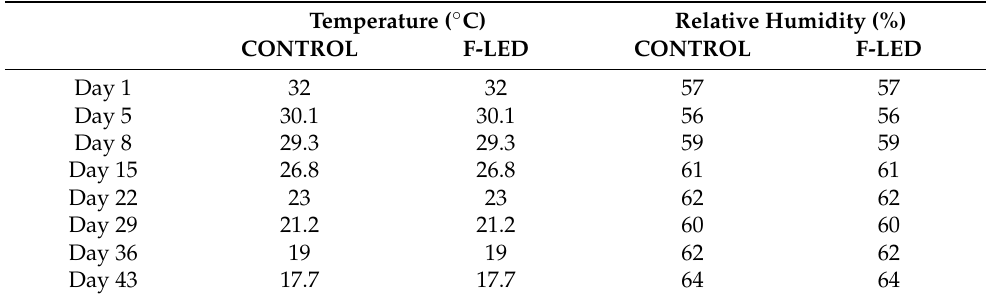
Table 2. Internal temperature and relative humidity recorded in the two poultry houses during the